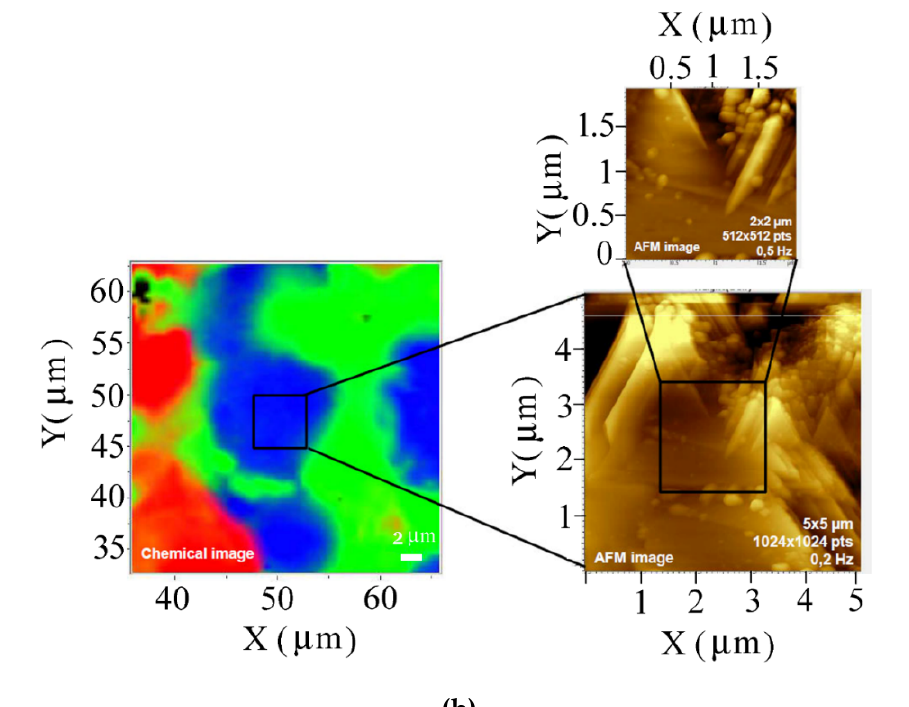
Figure 5. ( a ) Colour coded chemical image of clinker 217 obtained using Raman mapping with a HORIBA Jobin-Yvon Labram instrument. Spectra 1 and 4 were offset vertically for clarity. ( b ). Atomic force micrographs of the selected area of clinker 217 grain from ( a ). There are spherulites corresponding to amorphous CaCO 3 visible on top of the flat surface of portlandite.